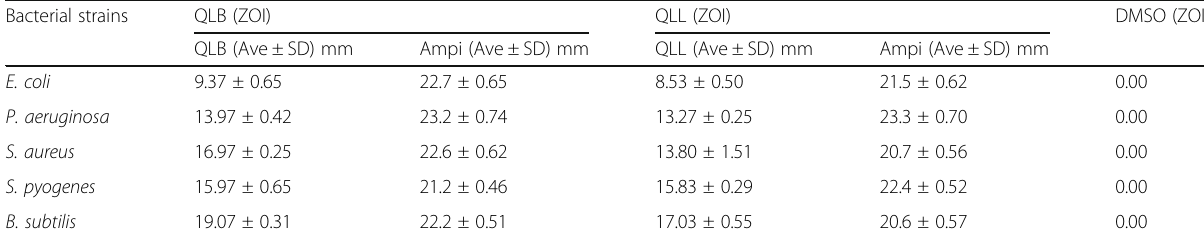
Table 3 Antibacterial profile of QL extracts Bacterial